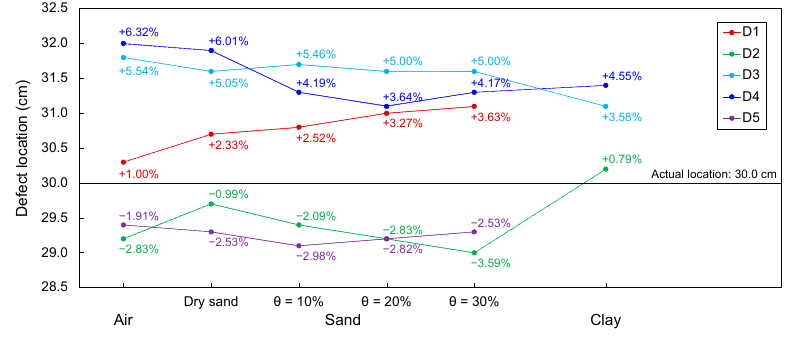
Figure 15. Estimated defect location and error.